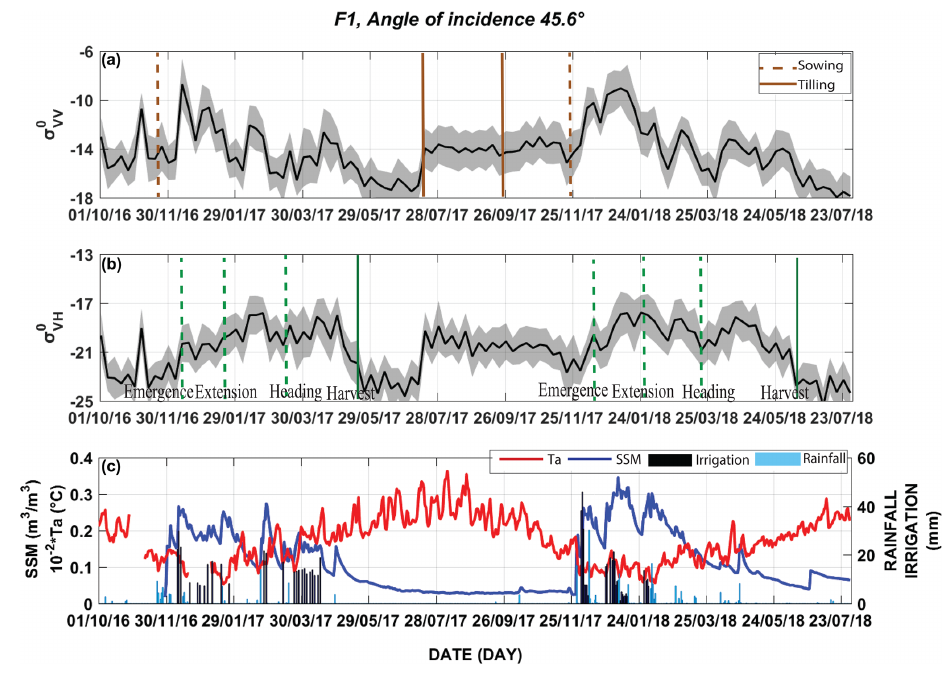
Figure A4. Time series of the backscattering coefficient at VV (a) and VH (b) polarizations on F1 at a 45.6 ◦ incidence angle during the period from 1 October 2016 to 31 July 2018. The tilling works and phenological stages of wheat are superimposed in panels (a) and (b) , respectively. The air temperature, surface soil moisture (SSM), irrigation and rainfall are displayed in panel (c) .